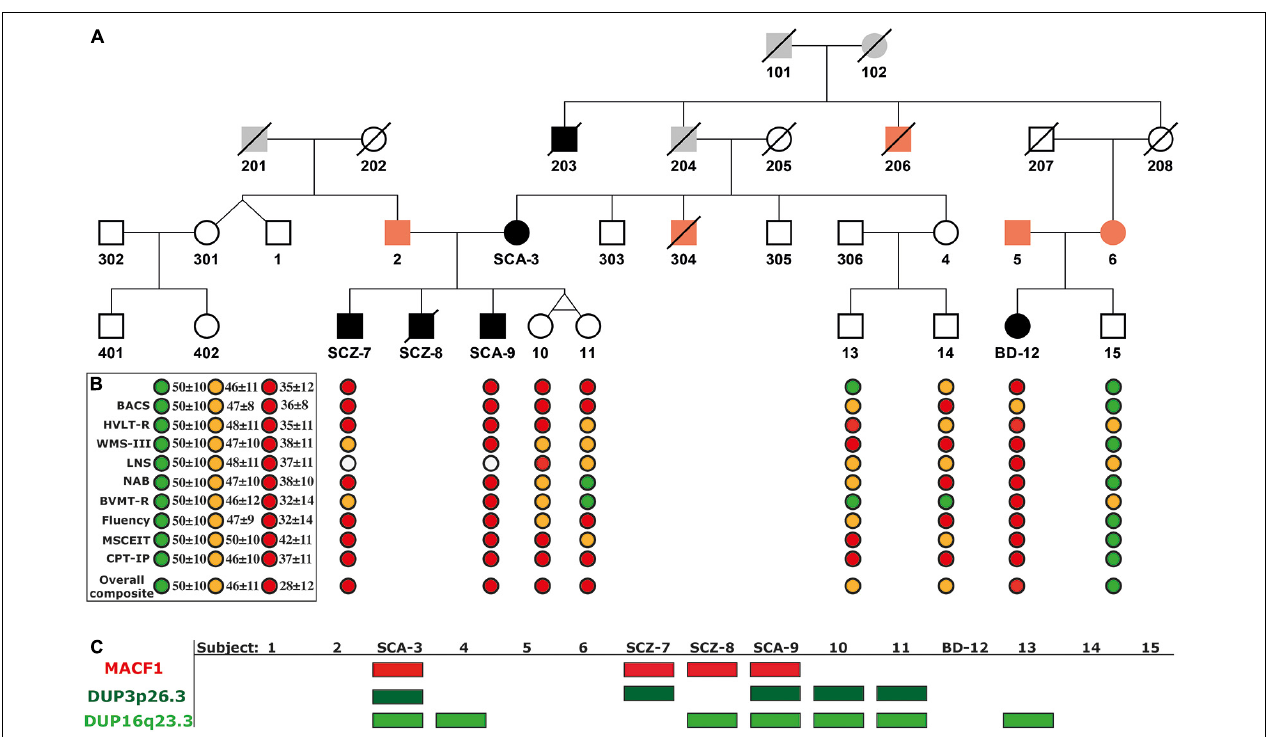
FIGURE 1 | Extended Pedigree of the Majorcan Family with the cognitive evaluation and the segregation of genomic variants associated with psychosis. (A) Pedigree. In black, subjects diagnosed with psychosis; in orange, subjects with a history of mental disorders without psychosis; in gray, unknown individuals. (B) Cognitive assessment. TMT, Trail Making Test (Part A); BACS, Brief Assessment of Cognition in Schizophrenia (Symbol coding); HVLT-R, Hopkins Verbal Learning Test-Revised; WMS-III, Wechsler Memory Scale-Third Edition (Spatial Span); LNS, Letter-Number Span Test; NAB Mazes, Neuropsychological Assessment Battery Mazes; BVMT-R, Brief Visuospatial Memory Test-Revised; Fluency: Category Fluency Test, Animal naming; MSCEIT, Mayer-Salovey-Caruso Emotional Intelligence Test; CPT-IP, Continuous Performance Test-Identical Pairs; Overall Composite Score, Cognitive index obtained summing all the tests scores and standardizing the result to a T score. In green, values of healthy controls; in orange, values of unaffected relatives with scores below the 25th percentile within their category; in red, values of patients with psychosis. (C) Segregation of the c.39,914,279 C > G mutation in the MACF1 gene and the duplications DUP3p26.3 and